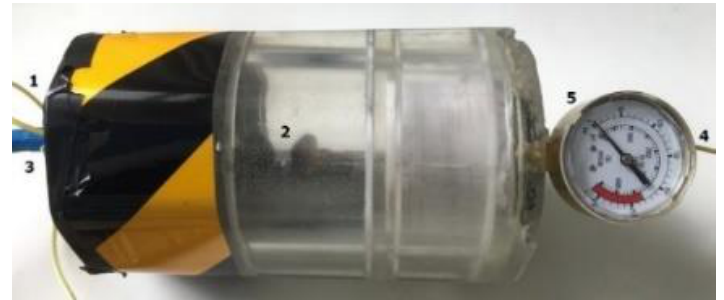
Figure 1. Test cell: 1. HV, 2. Sphere electrode, 3. Gas injection, 4. Ground electrode, 5. Pressure gauge.